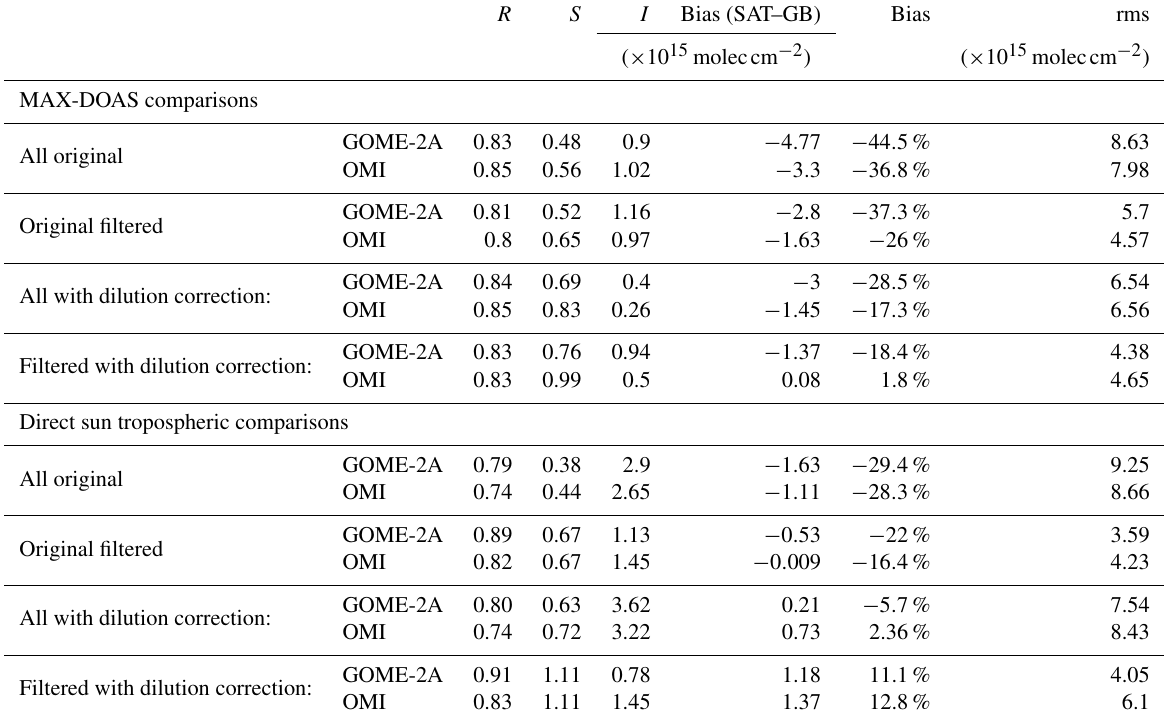
Table 5. Statistics of the monthly median comparisons of ground-based with satellite data for UIPP ensembles, before and after the 75 percentile filtering and the dilution correction are